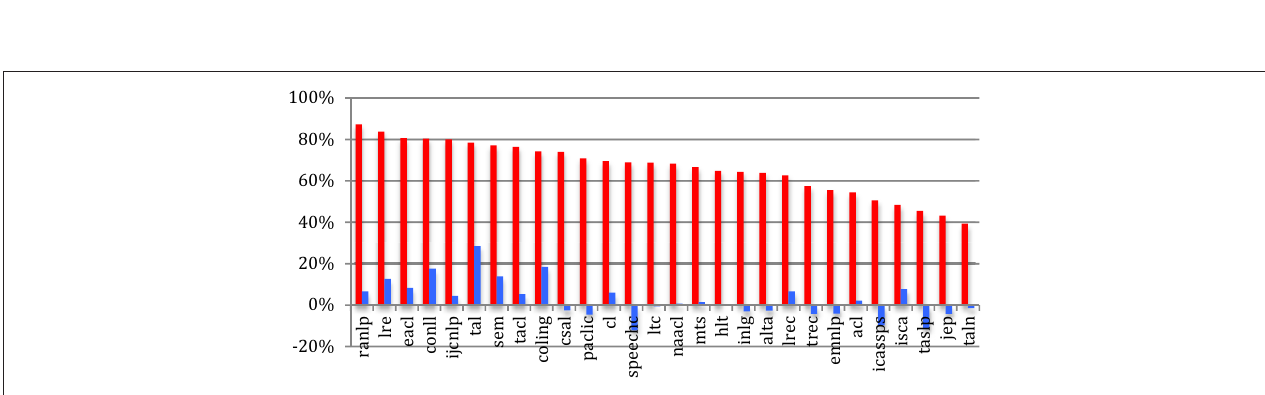
FIGURE 7 | Percentage of completely new authors in the most recent event across the sources in 2020 (red) and difference with 2015 (blue).